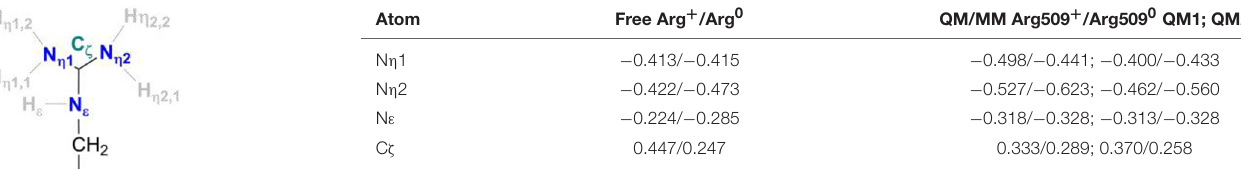
TABLE 2 | Charge distributions of a free arginine residue and the residue Arg509 of the E. coli [NiFe]-hydrogenase in their standard and neutral protonation states.